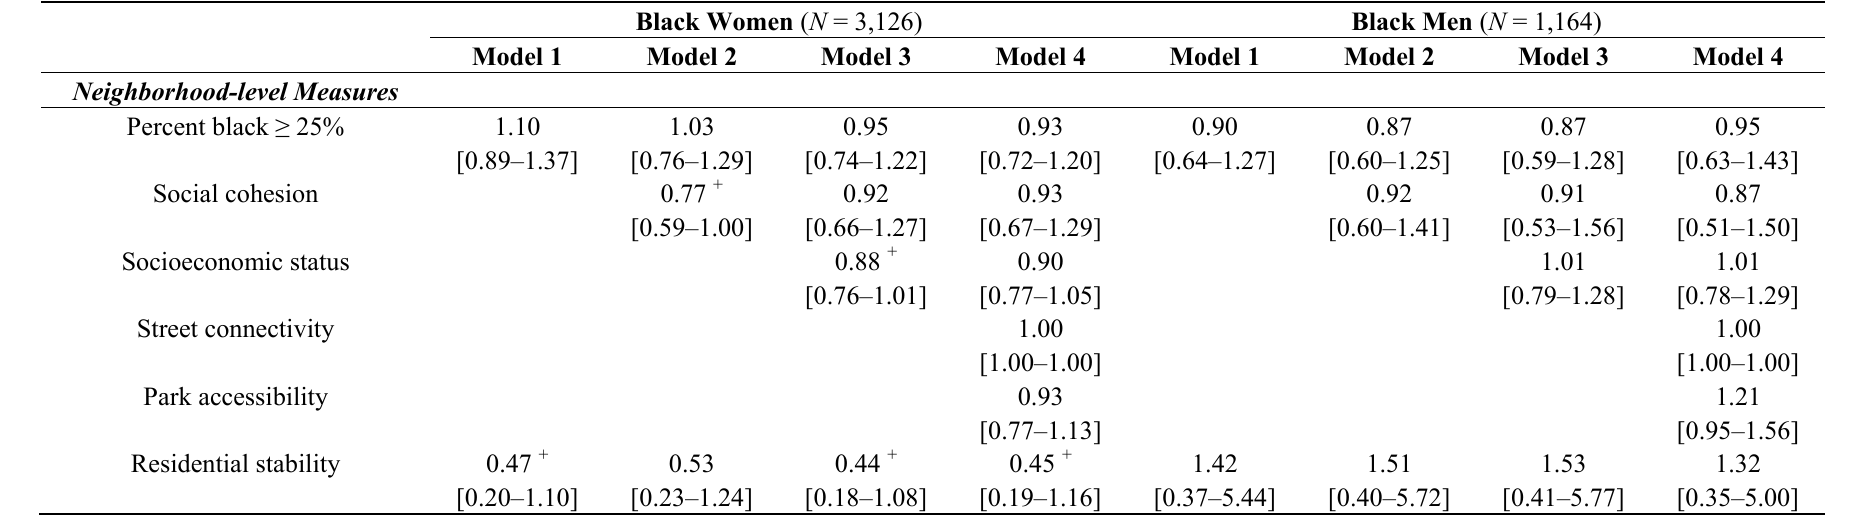
Table 4. Multilevel logistic regression odds ratio predicting obesity for black women and